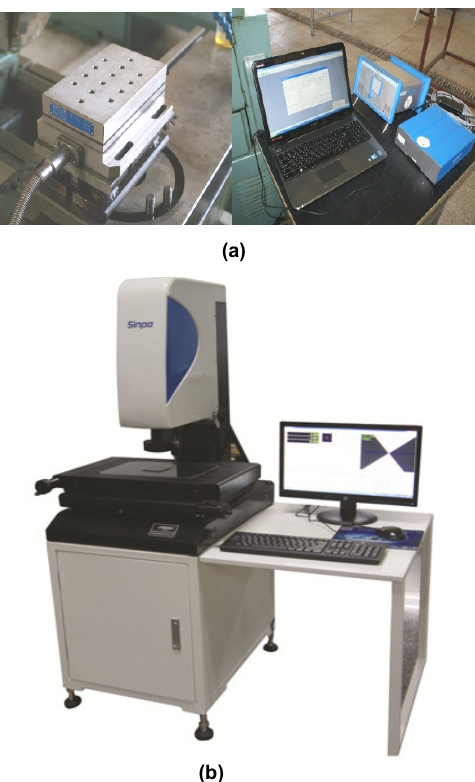
Figure 4. Devices used for the measurement of: (a) thrust force (KISTLER 9255B dynamometer); (b) circularity error (visual measuring machine).